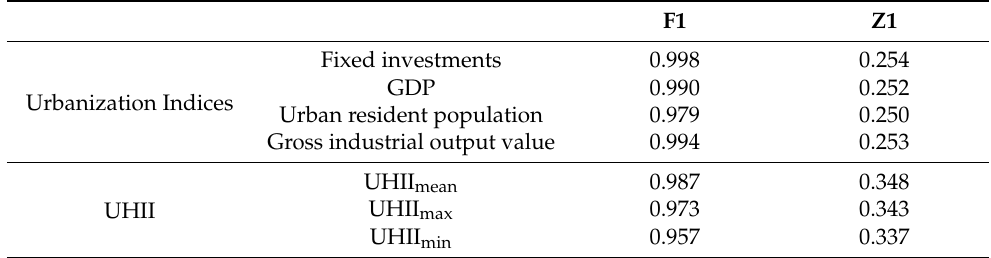
Table 8. Component load matrix (F1) and score matrix